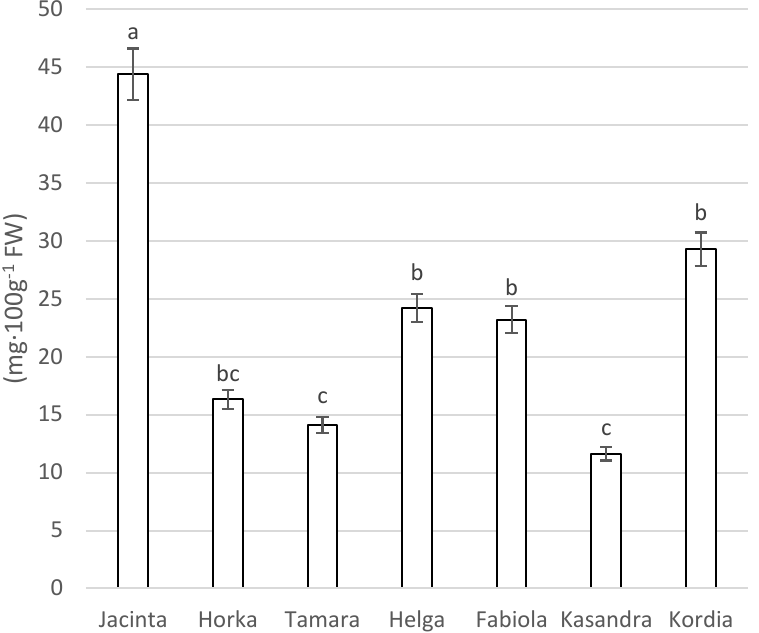
Figure 3. Flavonoid content, depending on cultivar. Values with different letters are significantly different.